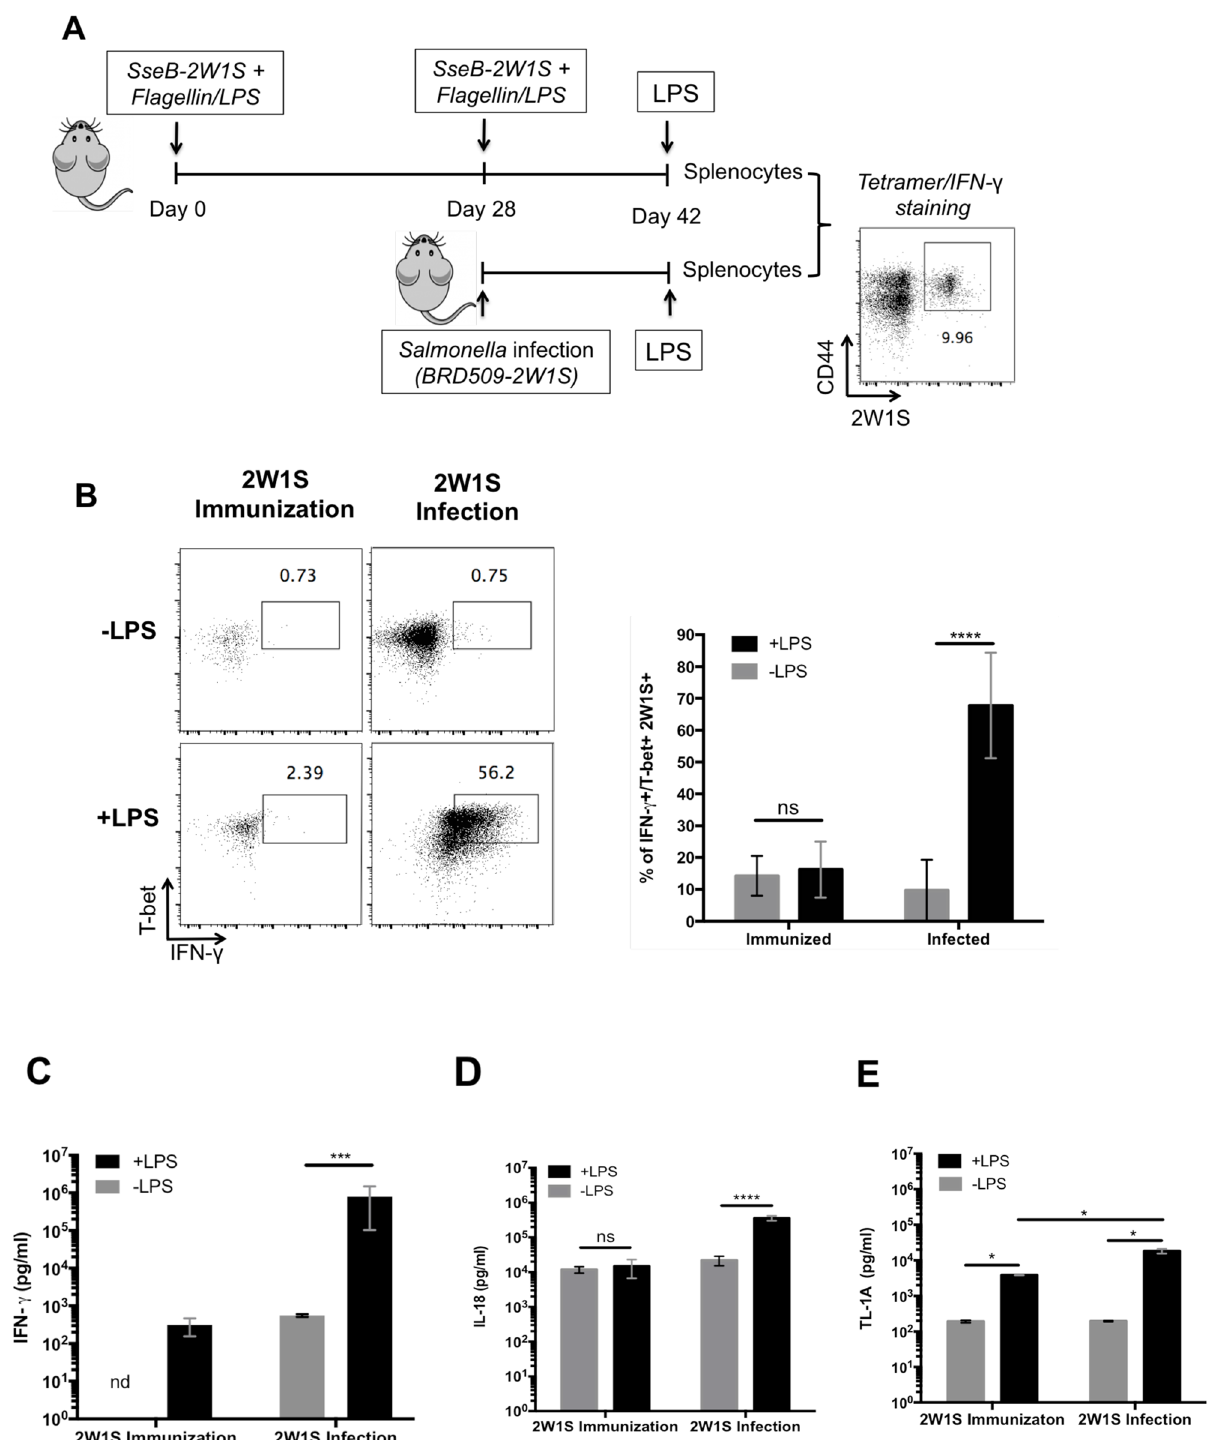
Fig 5. Th1 cells in immunized mice do not respond to non-cognate stimulation. (A) C57BL/6mice were immunized intravenously with a mixture 100ugof SseB-2W1S, 100ugflagellinand 10ug LPS twice at day 0 and day 28. As a positive control, C57BL/6 mice were infected i.v. with 5 × 10 5 Salmonella Typhimurium (BRD509-2W1S) at day 28 . Two weeks later, immunizedand infected mice were injectedi.v. with 10ug LPS. Spleensand serum were harvested4 hours later to examineIFN- γ productionof 2W1S-specific T cells by tetramer and IFN- γ /T- bet staining or ELISA. (B) Representative flow cytometry plots and a graph of combineddata are shown for the percentage of 2W1S-specific